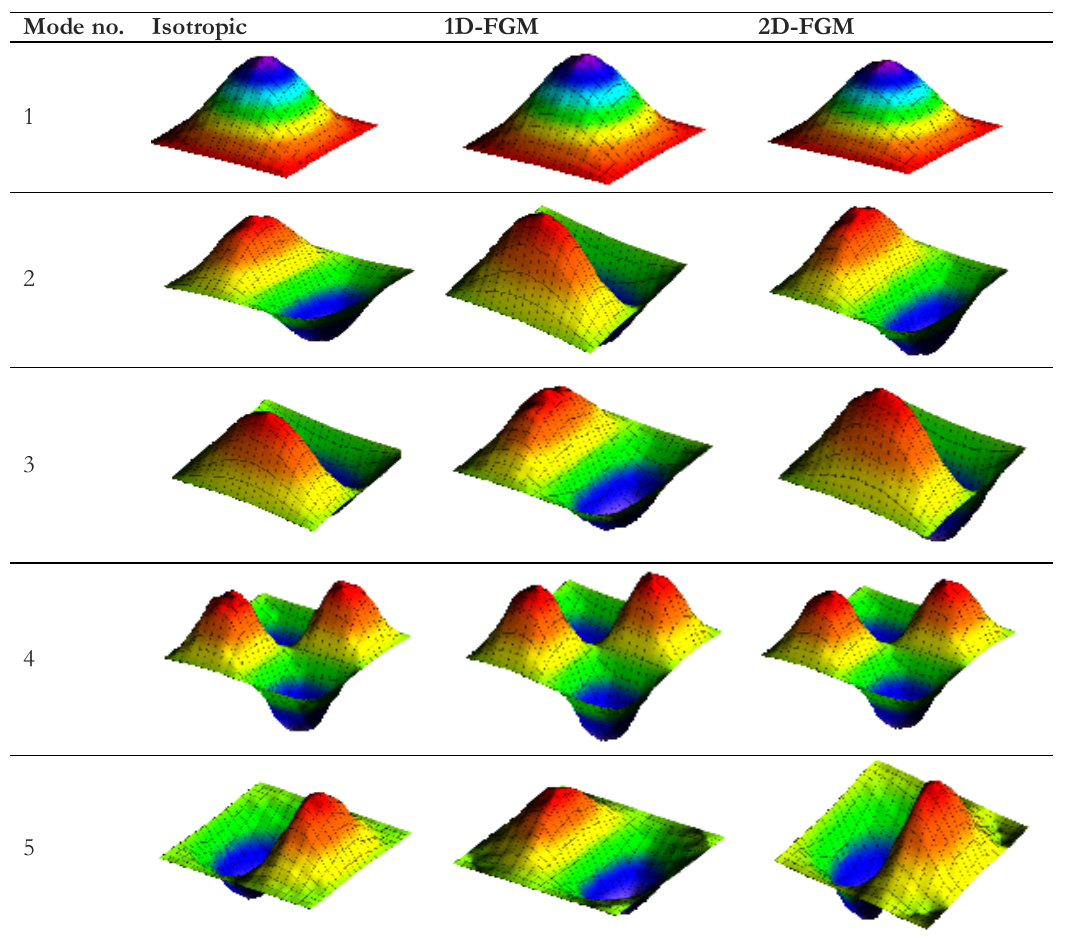
Table 8. First five mode shapes for isotropic, 1D-FGM and 2D-FGM fully clamped (CCCC) plate with (1-8-1) layer thickness ratio and a/h of